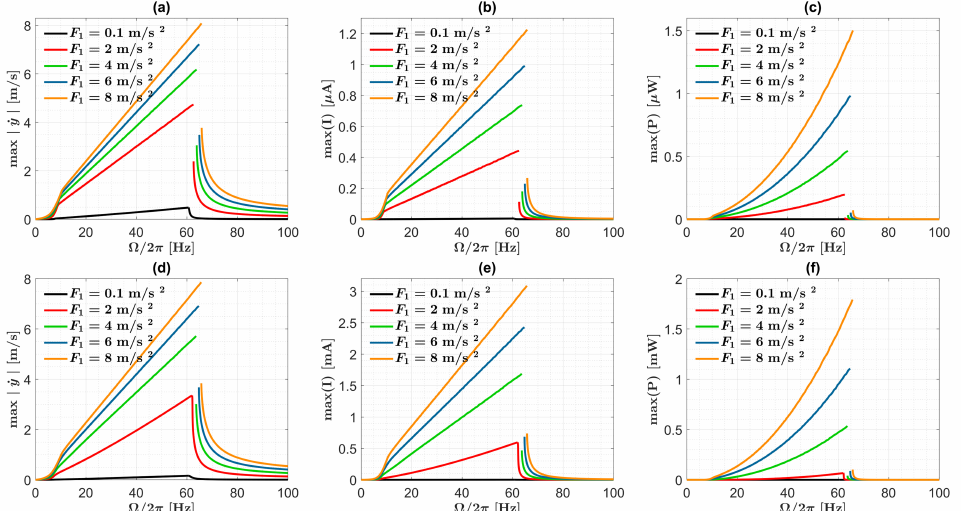
Figure 6. Optimal performance of the self-adaptive harvester using the optimal lengths computed for five excitation amplitudes: ( a – c ) | ˙ y M | , I M and P M for R l = 1 M Ω ; ( d – f ) | ˙ y M | , I M and P M for R l = 188 Ω